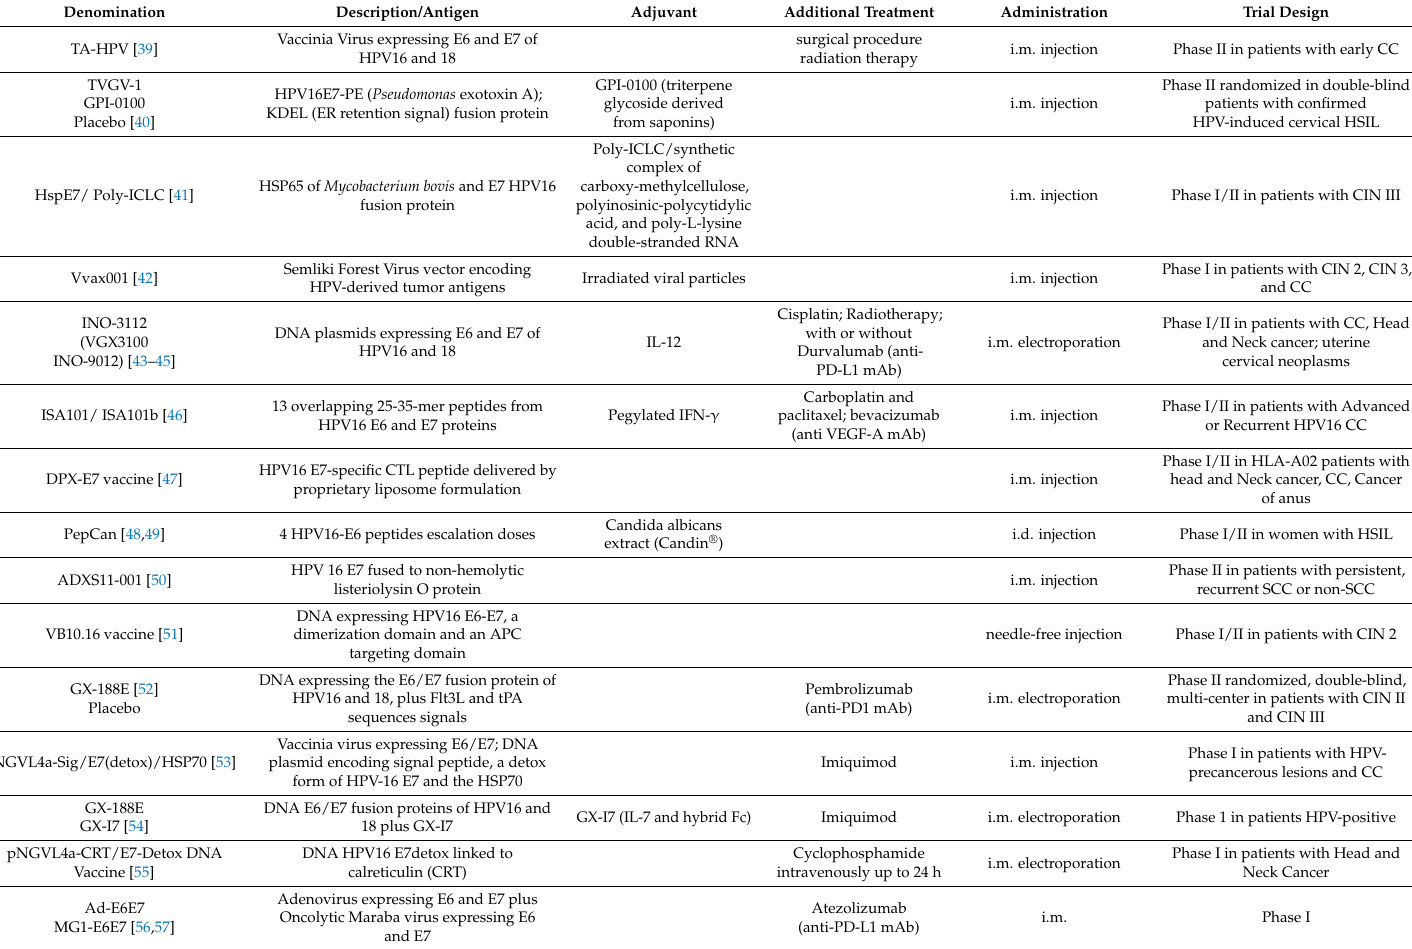
Table 1. Anti-human papillomavirus (HPV) therapeutic vaccines in clinical trials